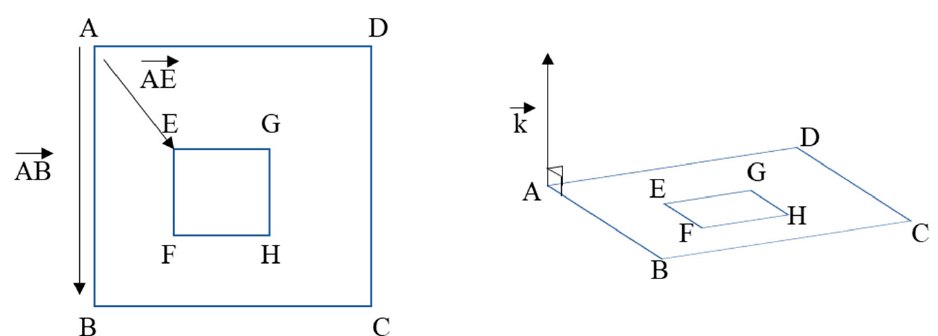
Figure 7. The outer product of the two anchor boxes to verify the worker’s QR code (i.e., ID).